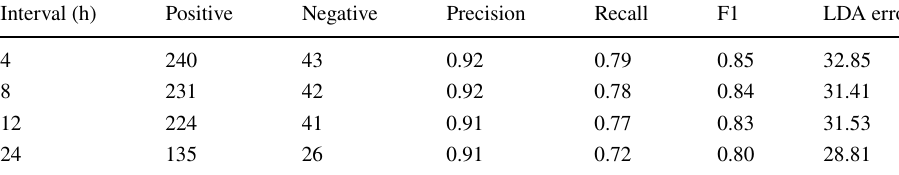
Table 5 The results:The results: SOFA criterion [3]